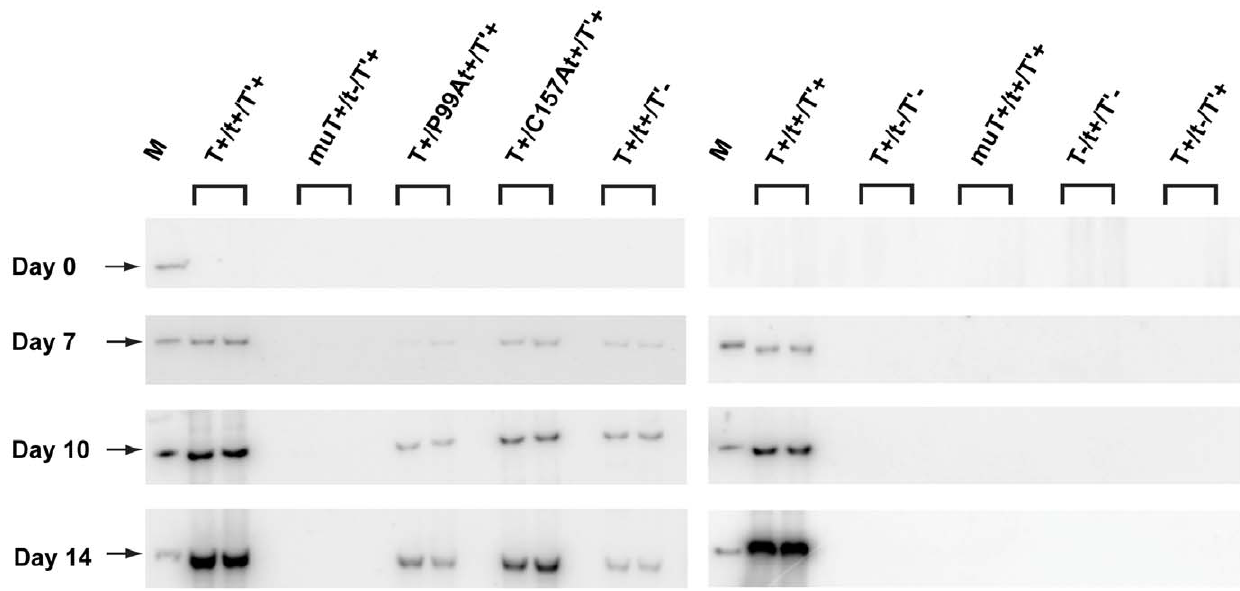
Figure 6. Mutation of tAg residues proline 99 and cysteine 157 reduce JCV DNA replication. PHFG cells in 60 mm plates were transfected in duplicate with 400 ng of wild type (T + /t + /T’ + ) or 8 different mutant (muT + /t 2 /T’ + , T + /P99At + /T’ + , T + /C157At + /T’ + , T + /t + /T’ 2 , T + /t 2 /T’ 2 , muT + /t + /T’ + , T 2 /t + /T’ 2 , T + /t 2 /T’ + ) JCV genomes. Duplicate, independent samples representing each DNA construct were extracted by the method of Hirt [39] on days 0, 7, 10 and 14 p.t. and analyzed using the Dpn1 assay as described in the legend to Figure 5. The marker (M) shown in the first lane of each blot is 1 ng of linear JCV DNA (5130 bp), and the position of Dpn 1-resistent replicating genomes is denoted by an arrow at days 7, 10 and 14 p.t.